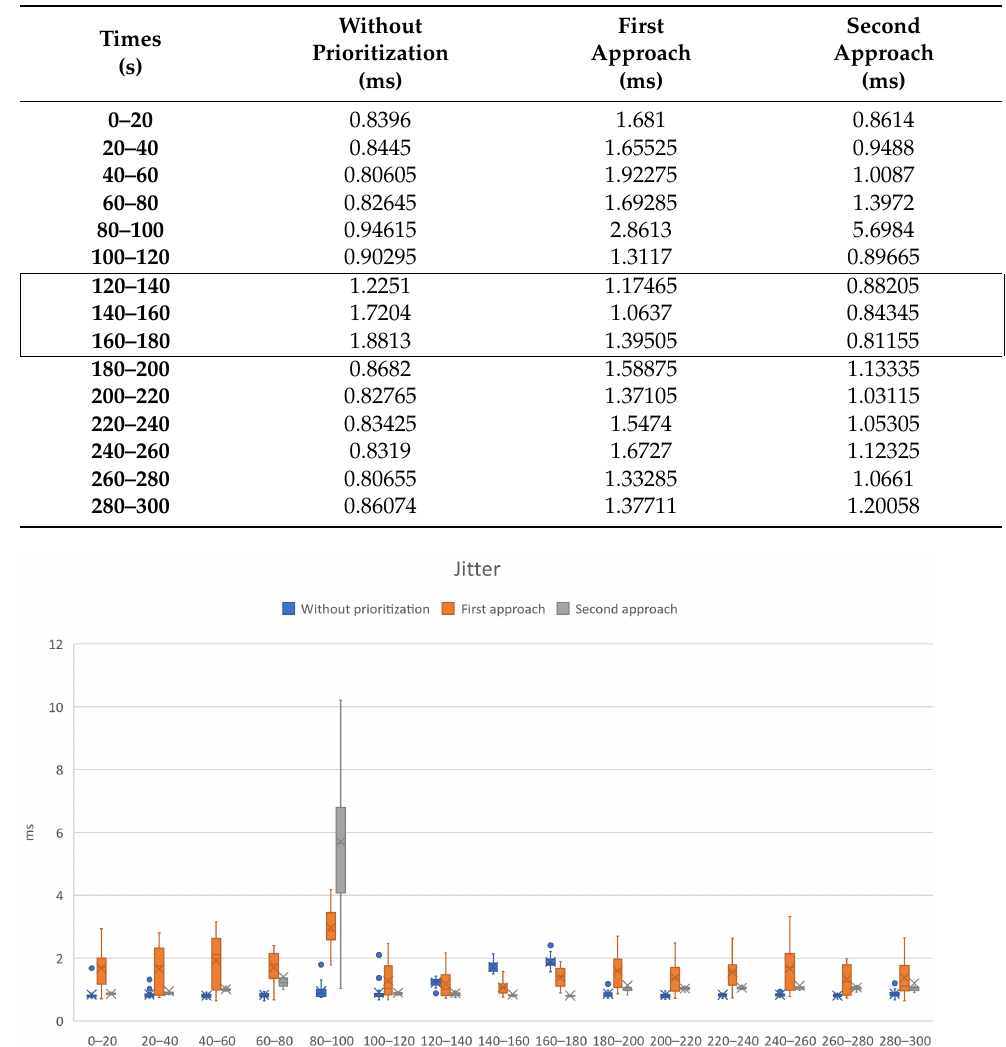
Table 8. Mean jitter values measured in each scenario in the Streaming slice.